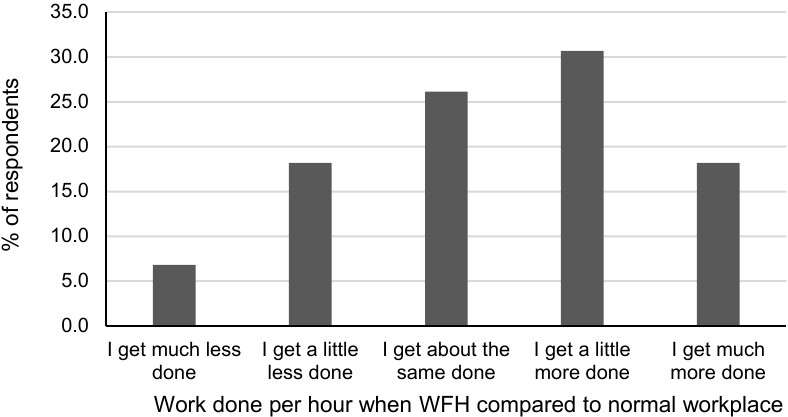
Figure 4. Work done per hour when WFH during the pandemic compared to normal workplace before the pandemic. Table 5. Self-reported work productivity, overall WFH satisfaction and future preference for WFH.